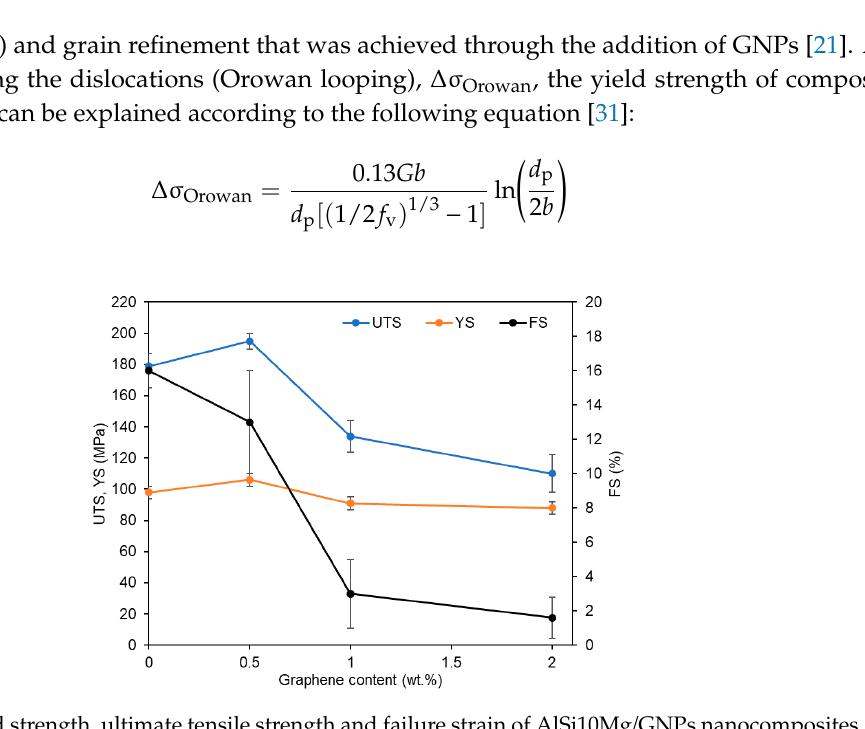
Figure 7. Yield strength, ultimate tensile strength and failure strain of AlSi10Mg/GNPs nanocomposites as a function of graphene content.